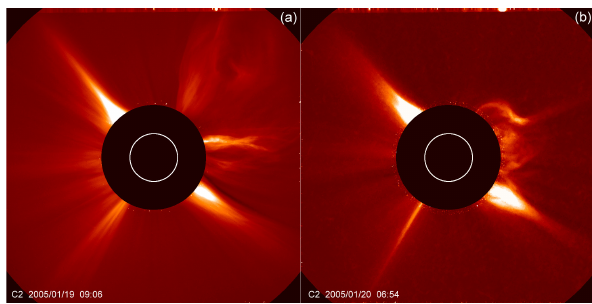
Fig. 9. (a) LASCO C2 image of the CME on 19 January 2005. Note the circular features towards the NW end of the FOV. (b) The only LASCO C2 snapshot of the CME on 20 January 2005. Due to the proton storm, the image looks blurred after cosmic ray